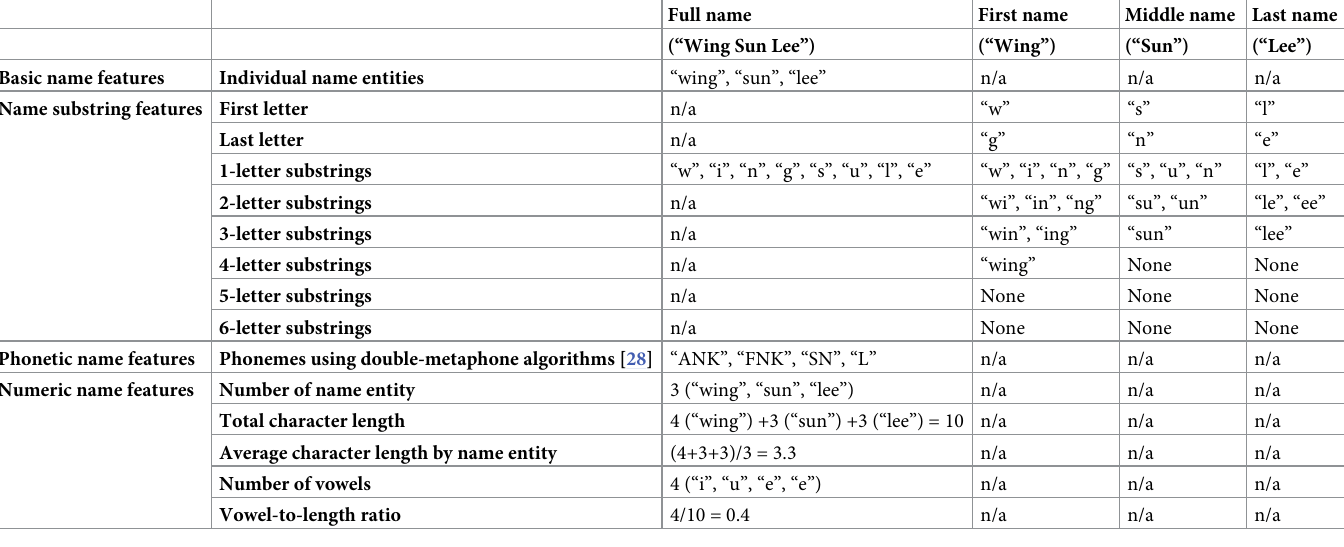
Table 1. Extraction and groupings of name